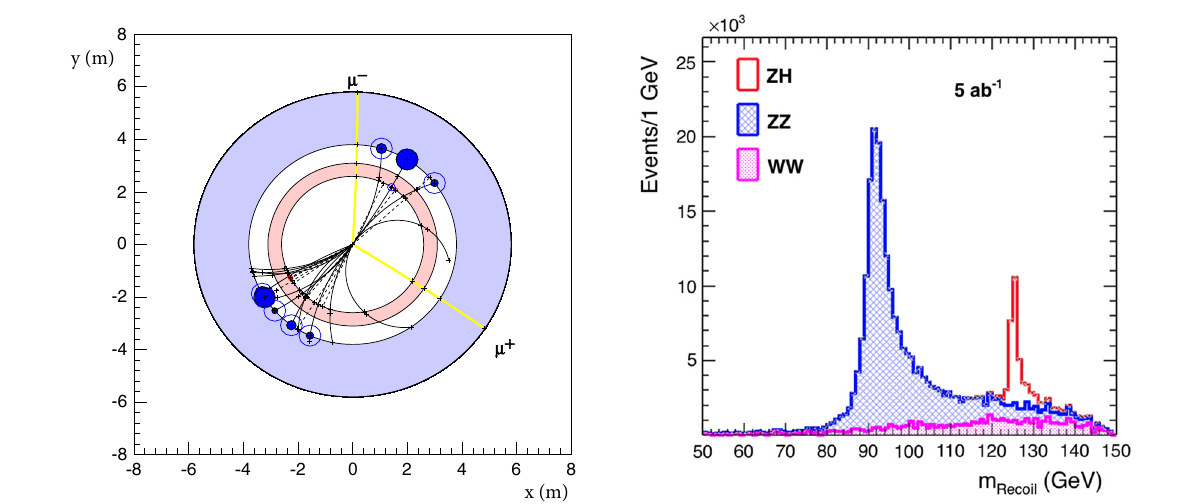
fromthetotalenergy-momentumconservation,withanintegratedlumi- nosityof5ab − 1 andtheCLDdetectordesign.Thepeakaround125GeV (in red) consists of HZ events. The rest of the distribution (in blue and pink) originate from ZZ and WW production √ s = 365 GeV